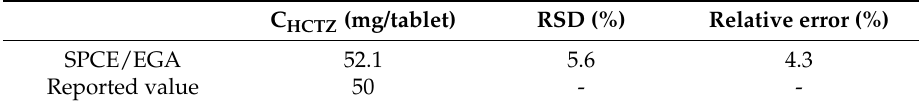
Table 3. Total concentration of HCTZ determined in three replicates of an anti-hypertensive drug by DPV on SPCE/EGA using standard addition calibration method in the presence of 0.01 mol L − 1 hydrochloric acid. Relative standard deviation (RSD) and relative error are also shown.